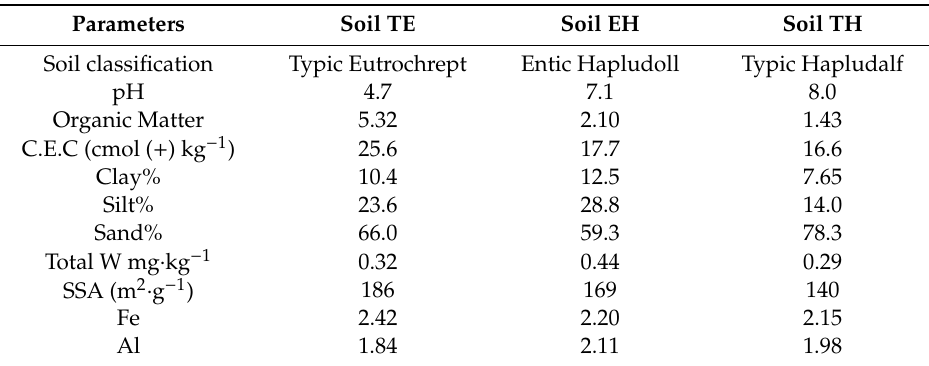
Table 1. Various properties of the soils